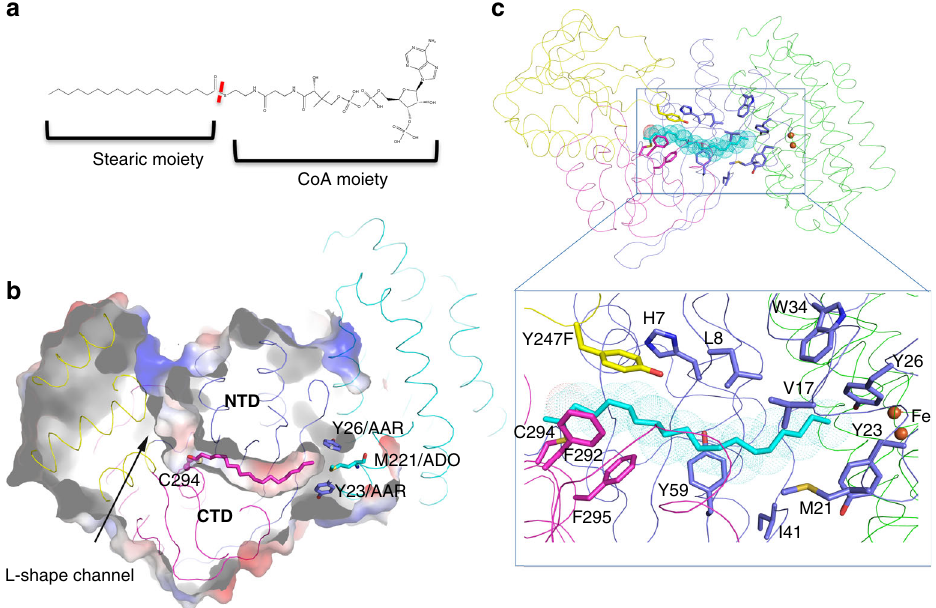
Fig. 2 AAR thioester – ADO structure. a Chemical structure of the substrate stearoyl-CoA. The red dashed line indicates the thioester bond between stearic chain and CoA moiety. b Surface representation of AAR thioester – ADO structure. The L-shaped channel within AAR is indicated. The stearic chain (shown as magenta stick), covalently bound with C294 (shown in stick-ball mode), is located in the hydrophobic tunnel, which is a part of the L-shaped channel. Residues Y23 and Y26 from AAR, and M221 from ADO, forming the terminal end of the tunnel, are shown in stick and labeled. The color code of AAR and ADO is the same as that in Fig. 1b. c The hydrophobic residues, mainly from the NTD and the CTD, are involved in the substrate tunnel formation and shown as sticks. The color code of AAR is the same as that in Fig. 1b, and ADO is shown in